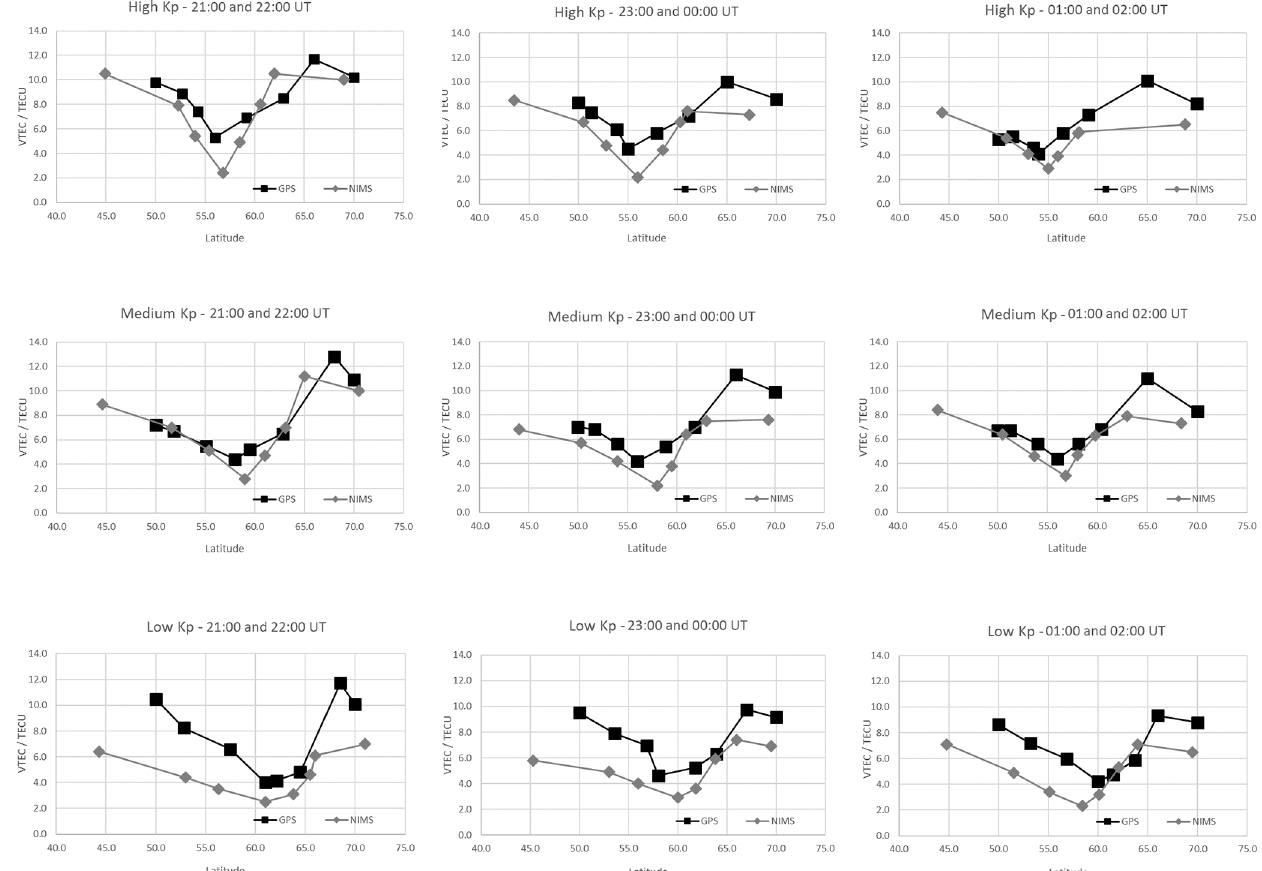
Figure 10. Parameterization profiles from the EDAM model with GPS assimilated data (black) for low Kp (0 to 2 + ) , medium Kp (3 − to 4) and high Kp ( ≥ 4 + ) and for the NIMS tomography observations (grey) from Pryse et al. (2006) for low Kp (0 to 2 + ) , medium Kp (3 − to 4 − ) and high Kp (4 to 7 + ) . The points show the median values for D E (equatorward extreme), B E (equatorward breakpoint), H E (equatorward half point), T M (trough minimum), H P (poleward half point), B P (poleward break point), P max (maximum on poleward side of the trough) and D P (poleward extreme) for three time bins. For EDAM, these were for the combined hourly values of 21:00 and 22:00, 23:00 and 00:00, and 01:00 and 02:00UT indicated on the panels. The corresponding time intervals for NIMS were 21:00 to almost 23:00, 23:00 to almost 01:00, and 01:00 to almost